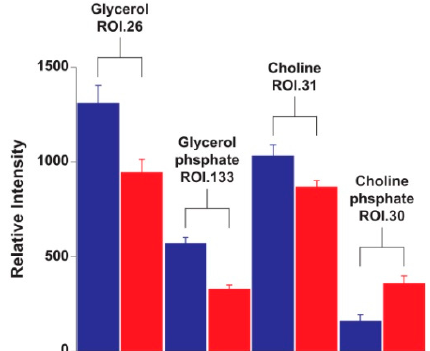
Figure 5. Quantitation of fatty acid-related metabolites in D 2 O extracts of Helicoverpa armigera larvae. Quantitation was performed on a single 1 H- 13 C HSQC ROI per metabolite. ROIs with the highest variability according to PCA loadings were selected. Herbivores = blue; cannibals = red.